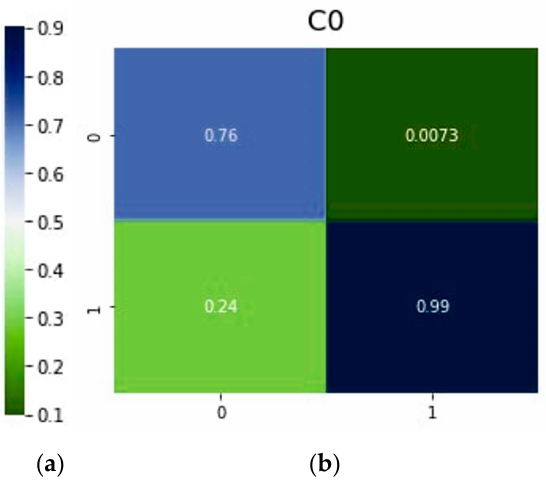
Figure 13. The color scheme for confusion matrices for the multi-classification model based on DeiT ( a ) and the confusion matrices for the C0 class ( b ).